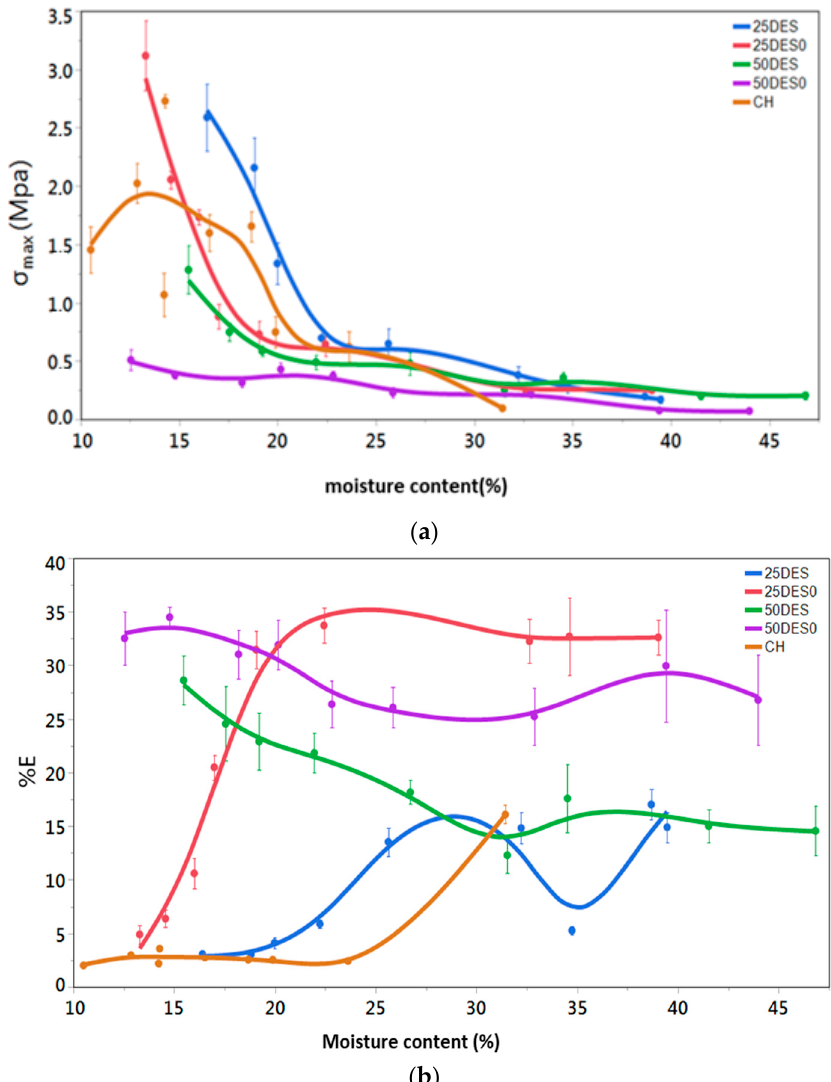
Figure 4. The effect of moisture content of the membranes ( a ) on the maximum tensile stress ( σ max) at the break and ( b ) on the percentage elongation (%E) at the break.